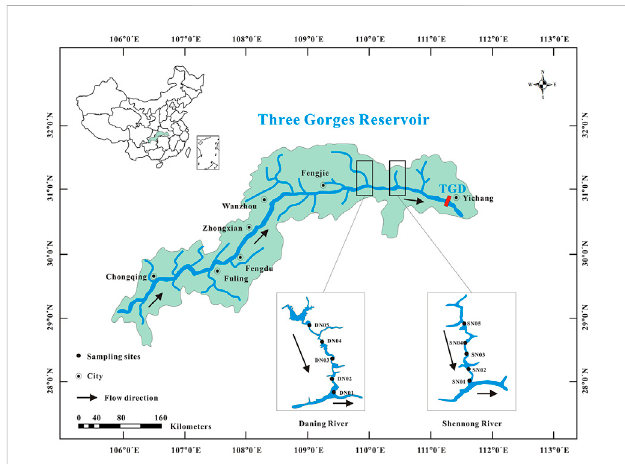
FIGURE 1 Study area and sampling sites in the Three Gorges Reservoir